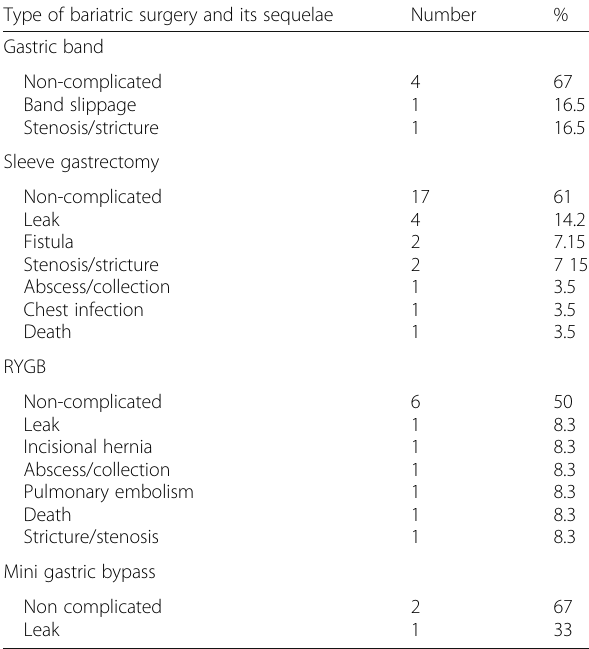
Table 4 Sequelae of bariatric surgeries and different complications related to type of surgery Type of bariatric surgery and its